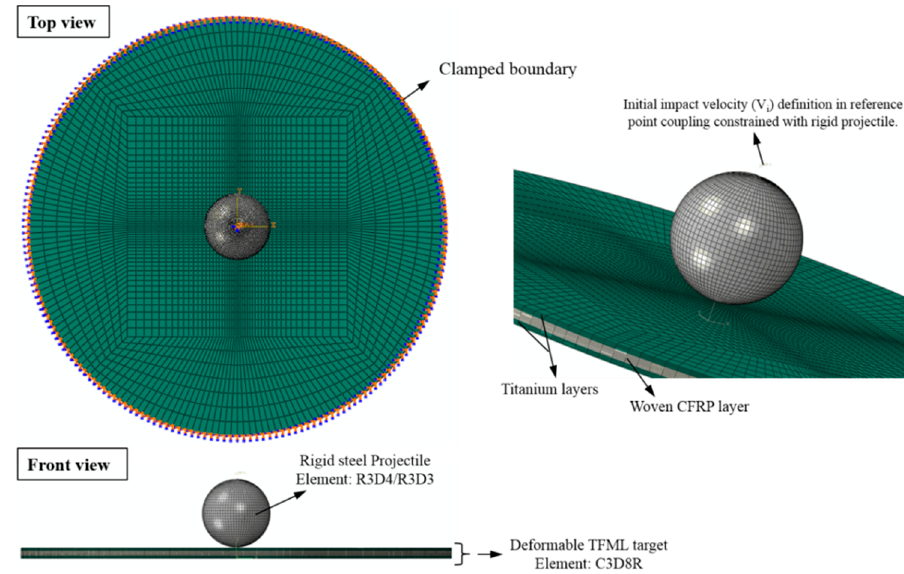
Figure 2. Finite element model and geometry.